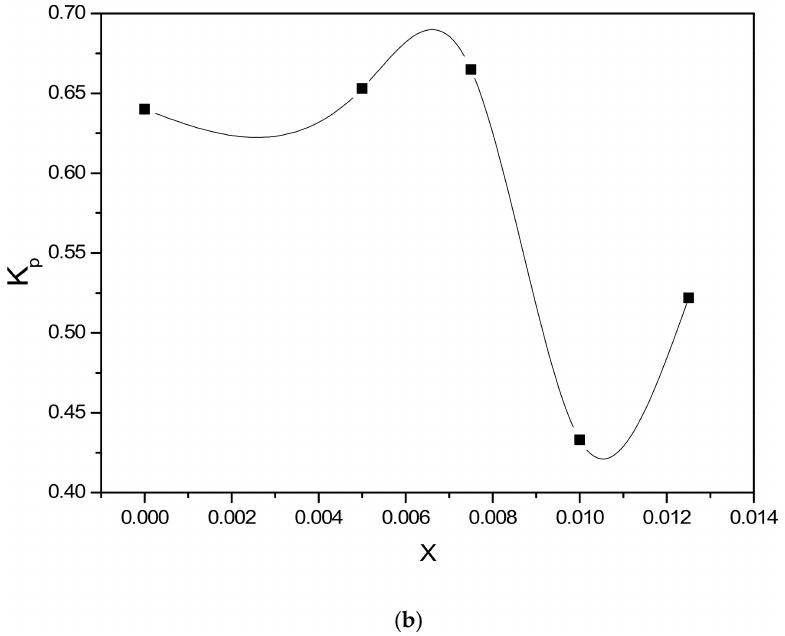
Figure 4. Impedance curve ( a ) and electromechanical coupling factor (k p ) ( b ) with Sm